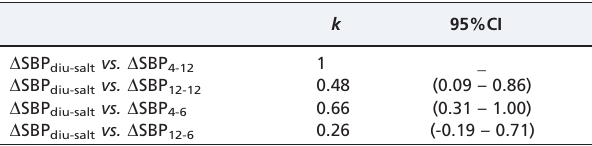
Table 4 - Kappa correlation (95% CI) between the variation in CS D SBP diu-salt in a salt loading and depletion protocol and the mean variation in SBP obtained by ABPM according to intervals of measurement (see text for details).